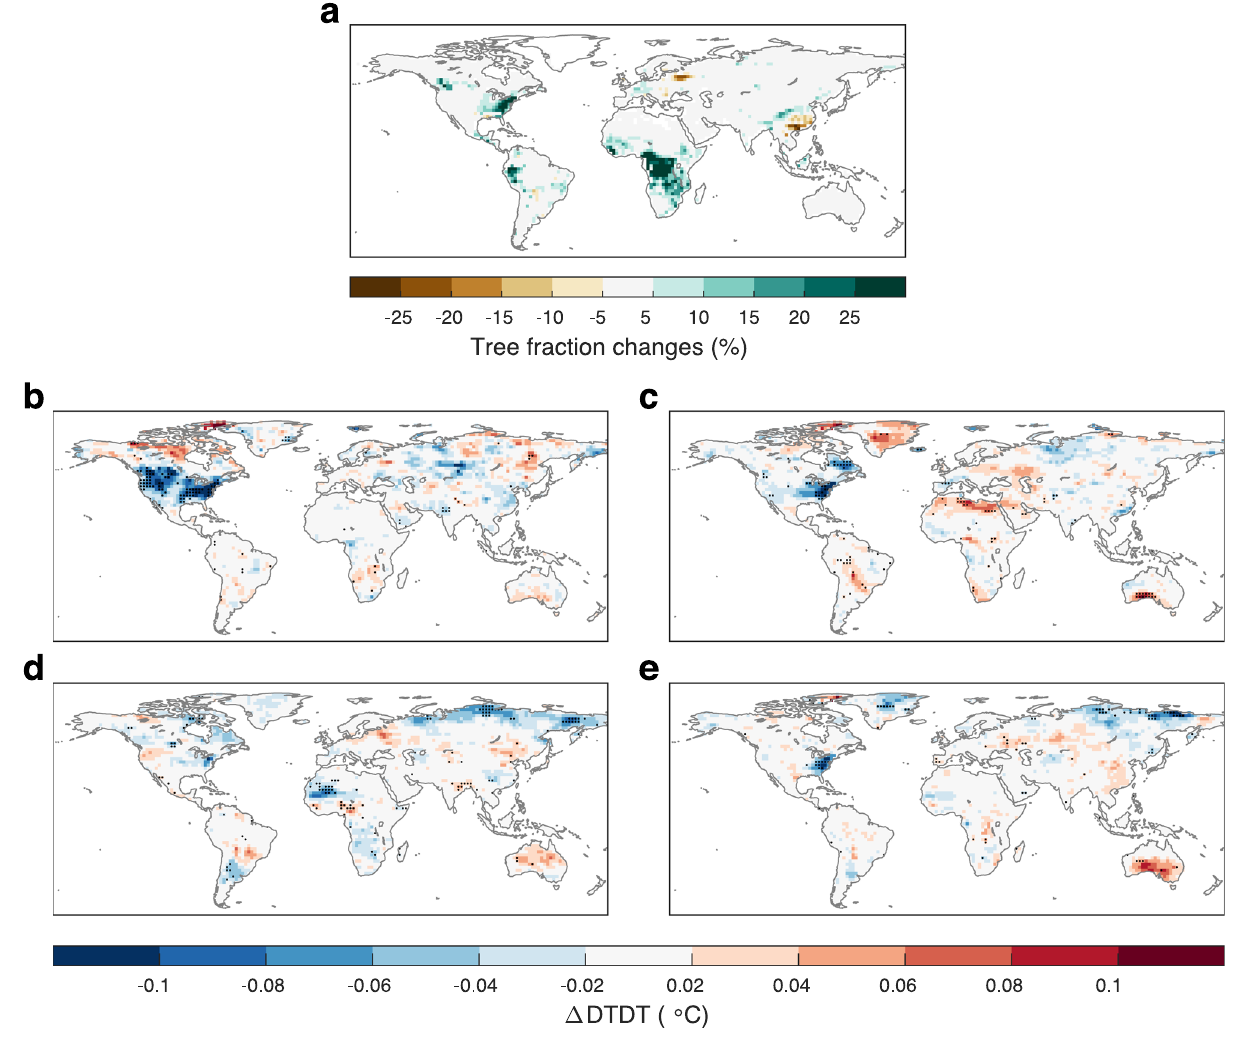
Fig. 6 | Potential tree cover changes by the end of the twenty- fi rst century and their effects on daily temperature variability. a Multimodel mean total tree fractiondifferencesbetweenthessp370andssp370-ssp126Lusimulations(ssp370- ssp126Lu minus ssp370) by the end of the twenty- fi rst century (2071 – 2100). b – e The biogeophysical effect of potential tree cover changes on